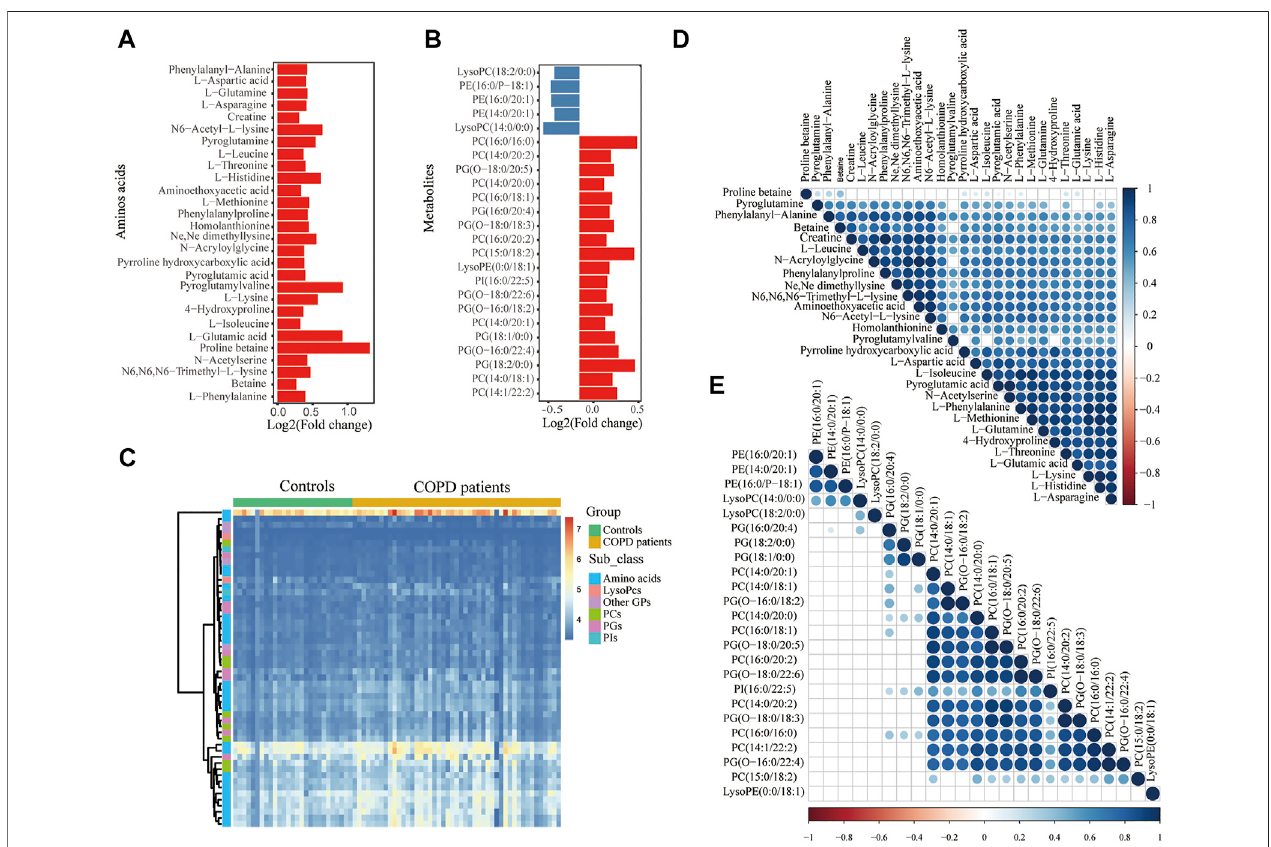
FIGURE3| Signi fi cantlychanged metabolism ofGPsand aminoacidsinCOPDin thereplicationset. Histogram ofsigni fi cantmetabolites ofglycerophospholipids (A) and amino acids (B) . The y -axis shows the metabolites, while the x -axis shows the value of log2 (fold change). (C) The heatmap shows differential GPs and amino acids of the COPD patients compared with the controls. Spearman correlation heatmap of (D) amino acids and (E) glycerophospholipids. The larger the circle and the darker the color indicate the greater the correlation coef fi cient. The circle is not displayed when the correlation is not signi fi cant. GPs, glycerophospholipids; PCs, glycerophosphocholines; PGs, glycerophosphoglycerols; PIs, glycerophosphoinositols; PEs, glycerophosphoethanolamines; amino acids: amino acids, peptides and analogs.